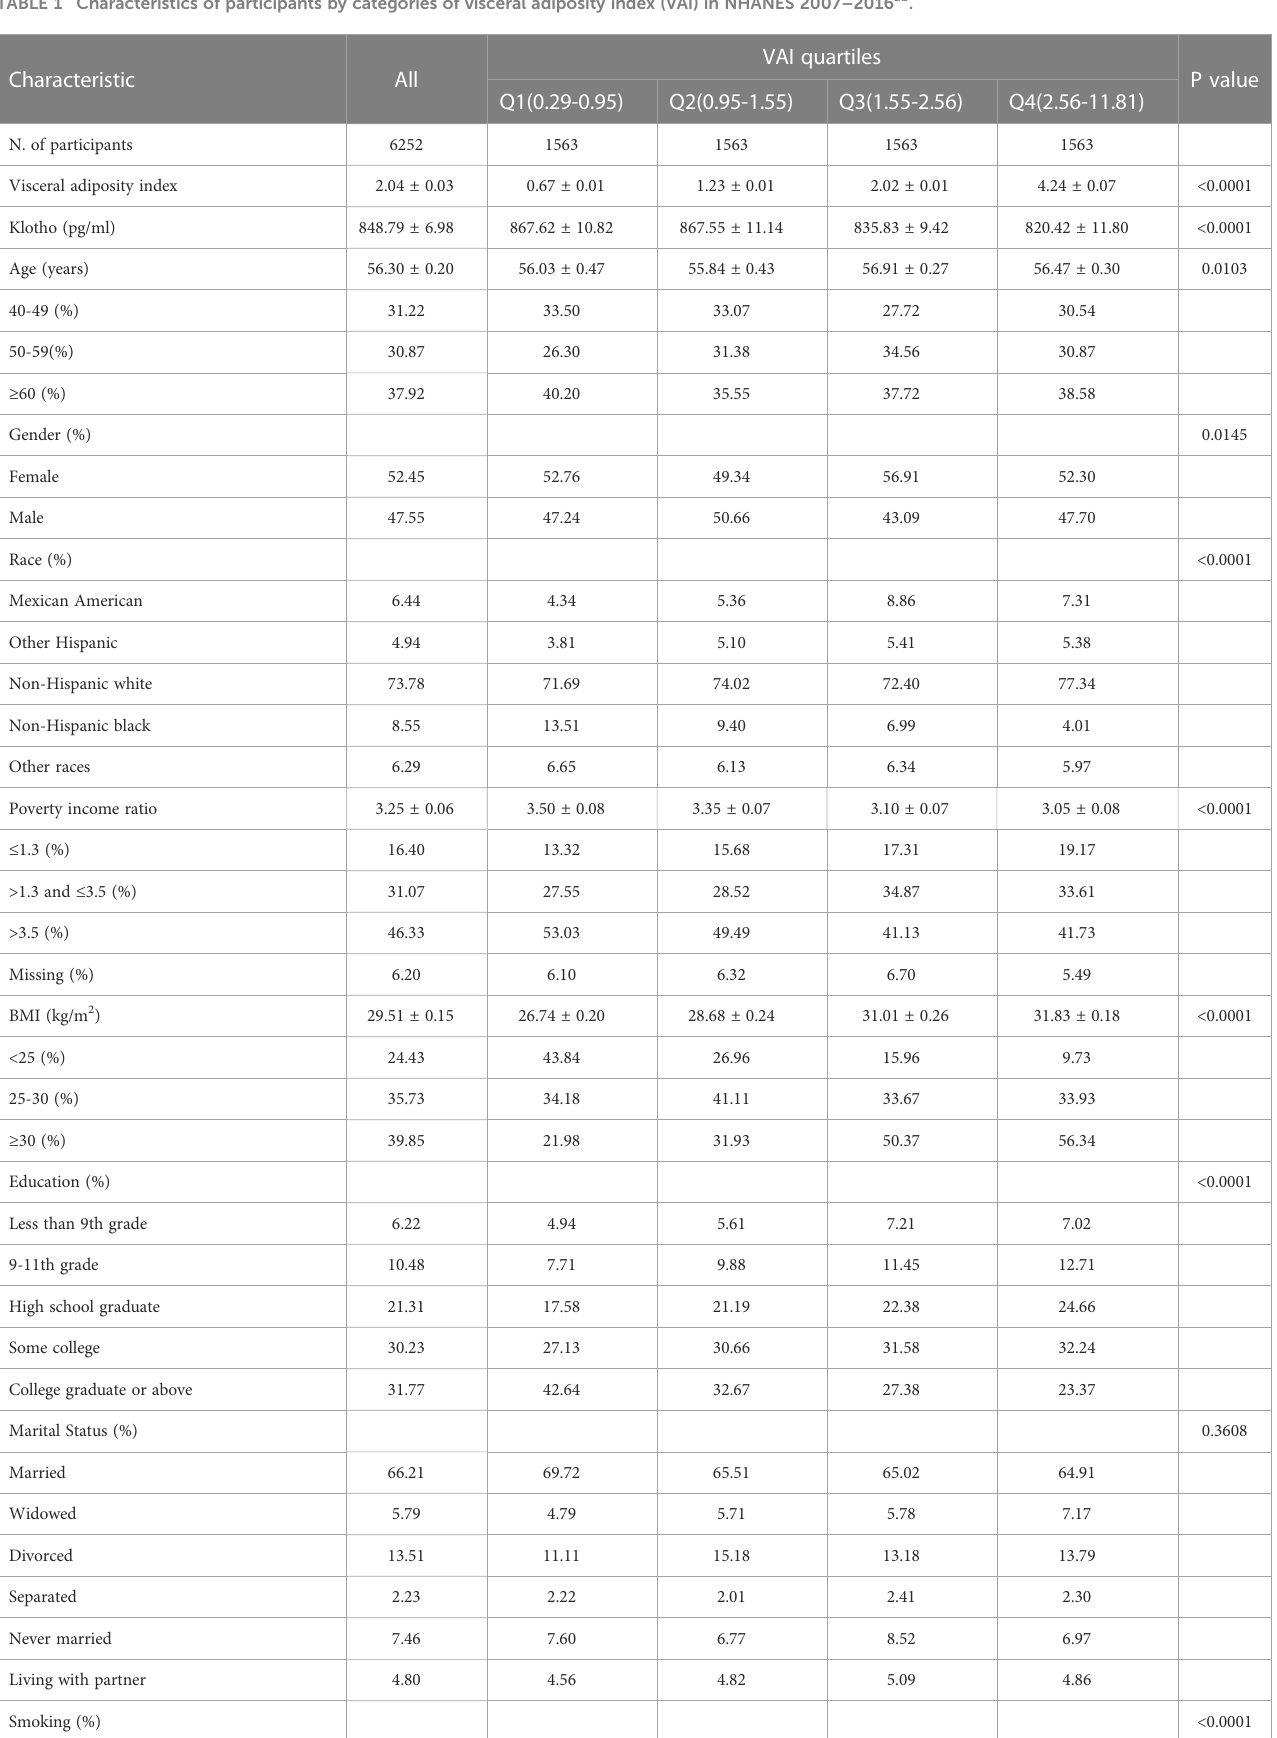
TABLE 1 Characteristics of participants by categories of visceral adiposity index (VAI) in NHANES 2007 – 2016 ab .